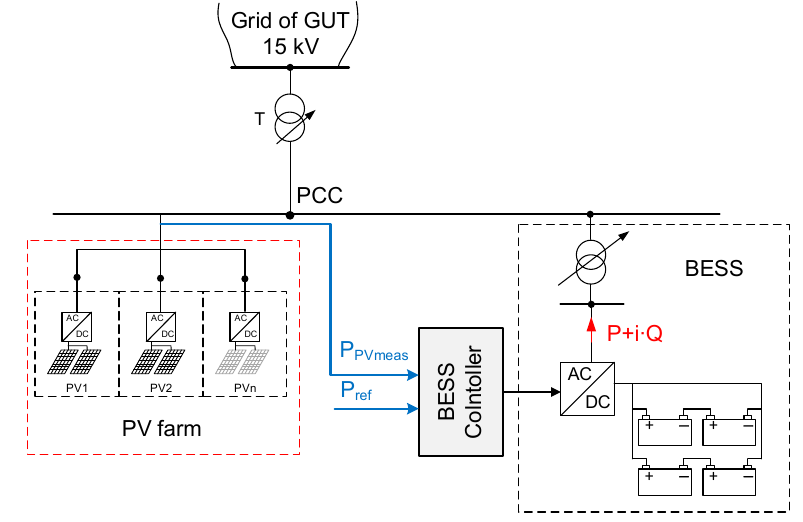
Figure 3. Test power system topology, T – power transformer 15 / 0.4 kV / kV, P PVmeas —measured power output of PV system, P ref – set power level for PV system, based on the declarations submitted to the day-ahead market (DAM) through balancing group and weather